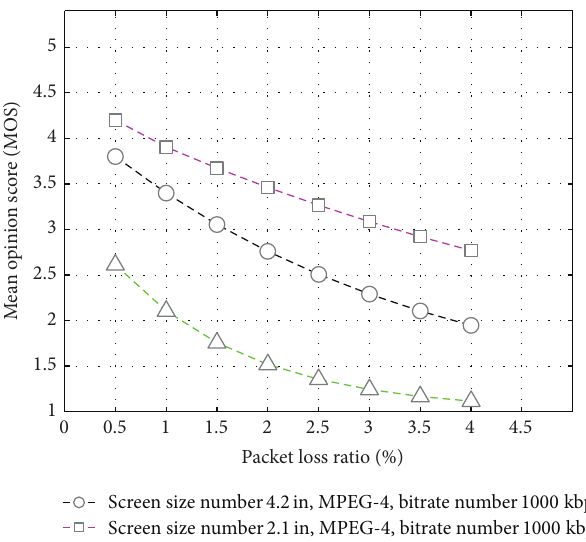
Figure 8: Estimated video quality on N-Screen devices versus packet loss ratio